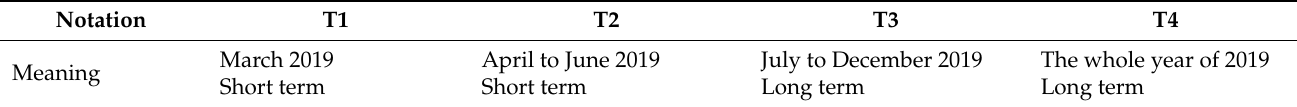
Table 1. Notations and their explanations about data.